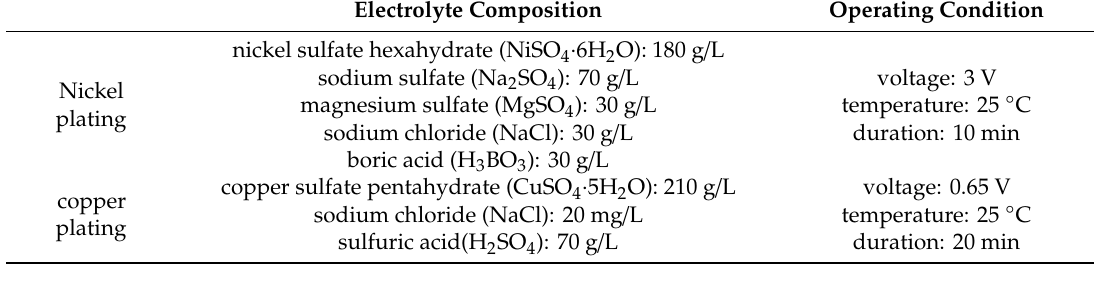
Table 1. The electrolyte and the operating condition.